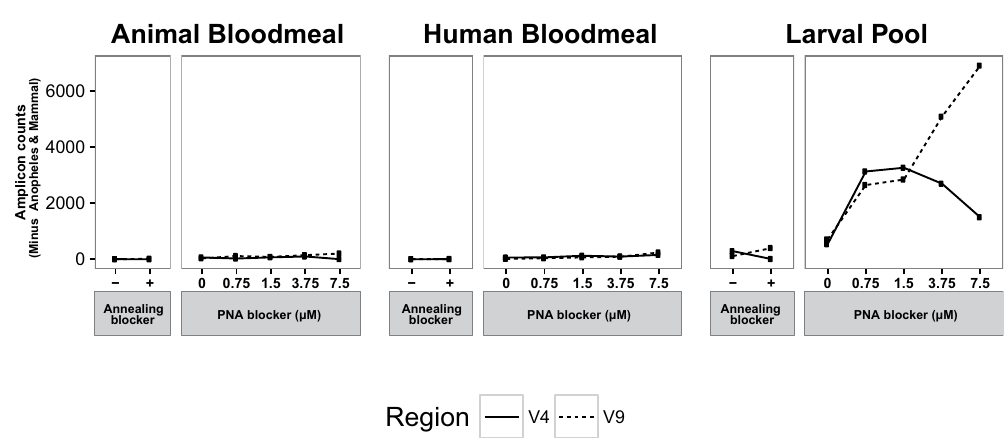
Figure 5. Efficiency of 18s rRNA gene blocking strategies for detection of the Anopheles eukaryotic microbiome. Anopheles and mammal 18s rRNA gene sequences were removed, and the numbers of 18s rRNA gene amplicons for the V4 (solid line) and V9 (dashed line) regions are indicated. The amplicon counts of non- Anopheles and mammal sequences indicates the efficiency of detection of eukaryotic microbiome lineages, shown as a function of blocking strategy used as well as PNA blocker